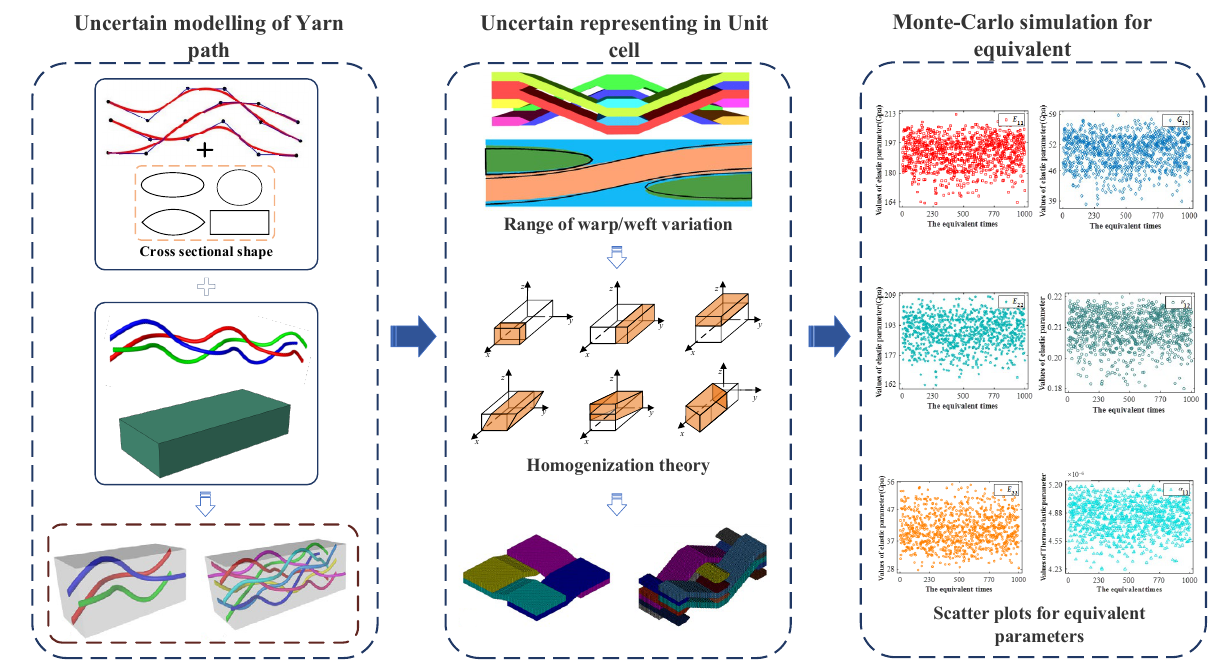
Figure 2. The process of equivalent modeling analysis. σ ij and ε kl are stress and strain tensors, f is the strength received in the R domain, ρ is the volume density, and C ijkl is the elastic tensor of the constitutive equation. On the ̅ boundary S σ and S u , the continuum satisfies the following equation under the basic and natural boundary conditions: